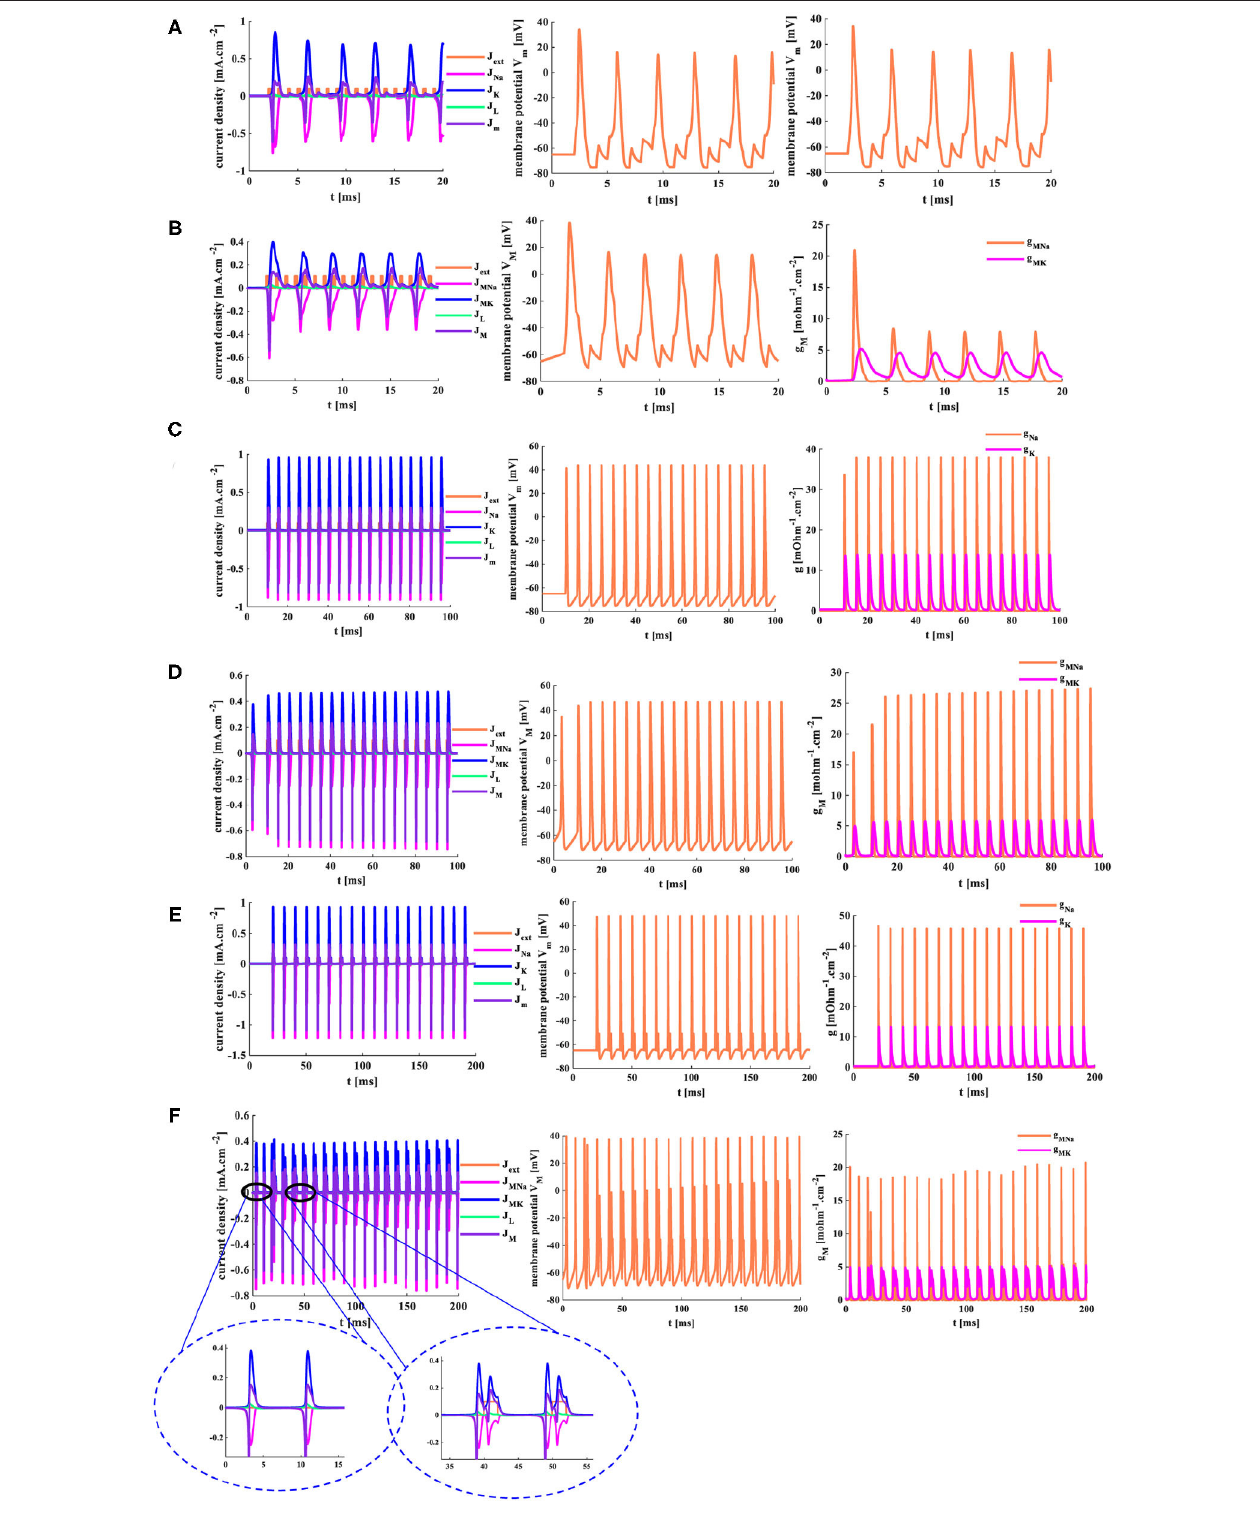
FIGURE 13 | The distinct action time of the external stimulus is set for the two models. (A) The HH spiking model with 20 ms action time. (B) The MHH spiking model with 20 ms action time. (C) The HH spiking model with 100 ms action time. (D) The MHH spiking model with 100 ms action time. (E) The HH spiking model with 200 ms action time. (F) The MHH spiking model with 200 ms action